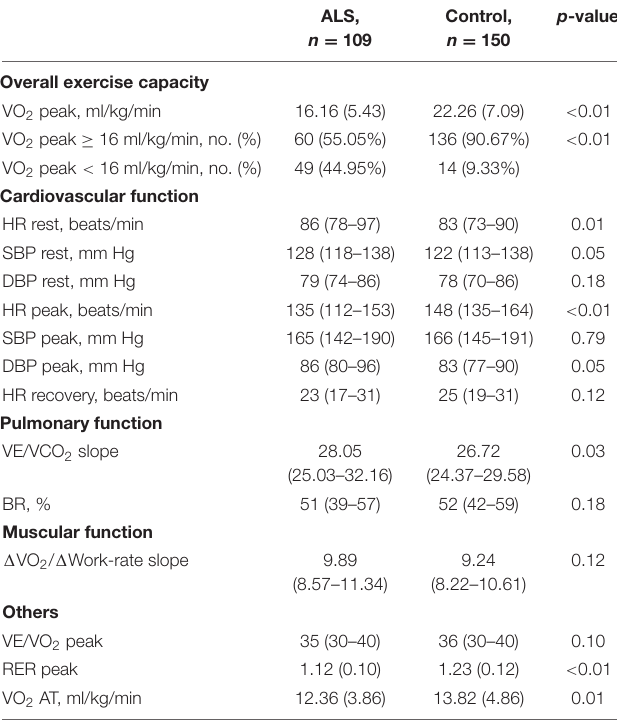
TABLE 2 | CPET assessments of patients with ALS and controls.